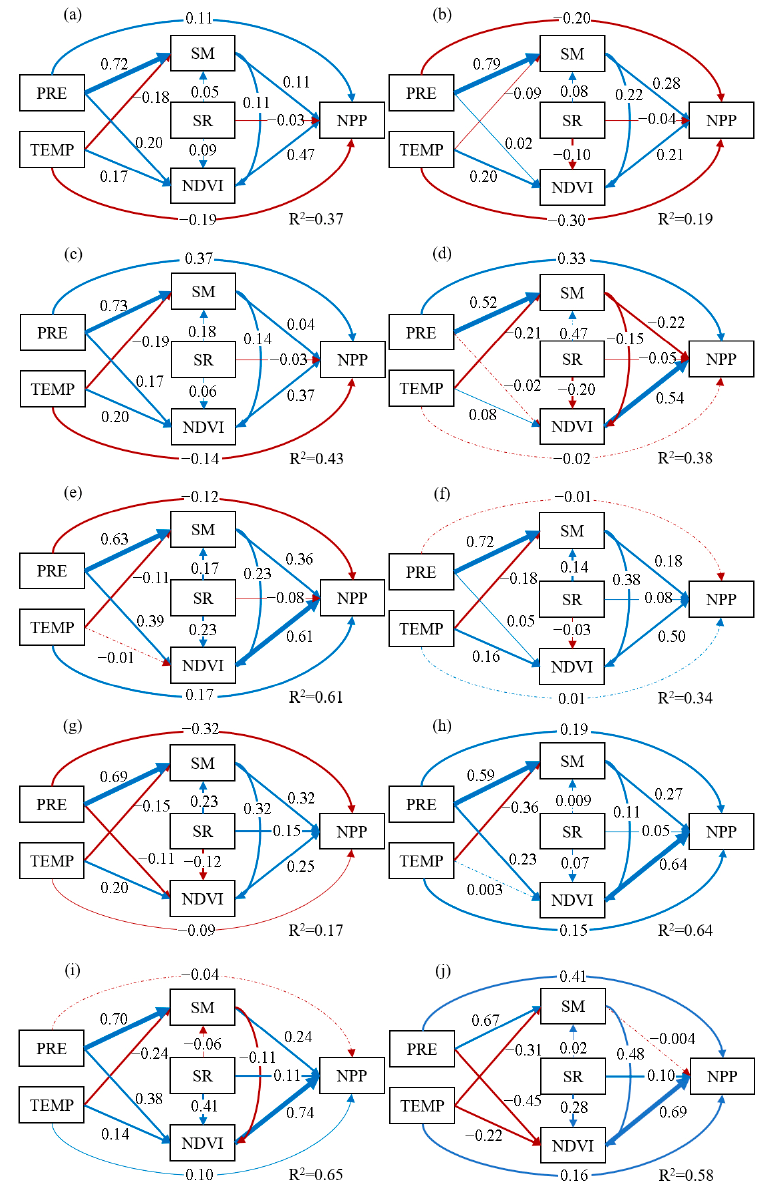
Figure 10. The established SEM for NPP in the MP ( a ) and different vegetation types (( b ): MSP; ( c ): TSP; ( d ): DSP; ( e ): ASP; ( f ): CRF; ( g ): BLF; ( h ): SLD; ( i ): SHR; ( j ): CRP). Note: The thickness of the arrows was proportional to the standardized path coefficients shown on each arrow. Blue lines represent positive effects; red lines represent negative effects; solid lines represent significant paths ( p < 0.05); dotted lines represent insignificant